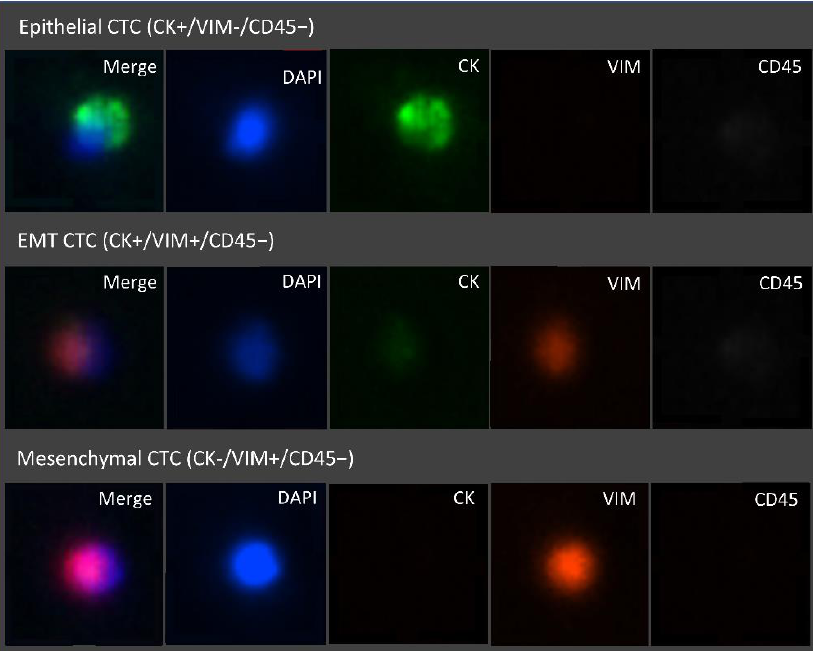
Figure 9. Representative fluorescence microscopic images of the different CTC phenotypes trapped inside the microfluidic device. Isolated cells trapped were stained with FITC Anti-Cytokeratin, Alexa Fluor 647 Anti-CD45, eFluor 570 Anti-Vimentin, and the nuclear stain DAPI. From top to bottom, epithelial (DAPI+/CK+/VIM − /CD45 − ), epithelial to mesenchymal transition (DAPI+/CK+/VIM+/CD45 − ) and mesenchymal (DAPI+/CK − /VIM+/CD45 − ) CTCs are represented. Images were acquired and observed with a 10×objective.